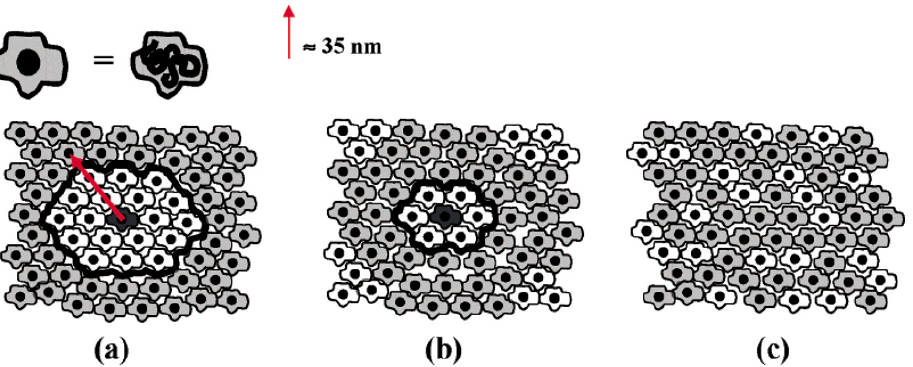
Figure 4. Schematic representation of the mixing length scales of ( a ) the PIB/PEB-23 blend and ( b ) or ( c ) the PIB/PEB-66 blend. For the latter, both representations are possible since the length scale is less than 70 nm in both cases. Reprinted with permission from reference [83]. Copyright 2004 American Chemical Society.